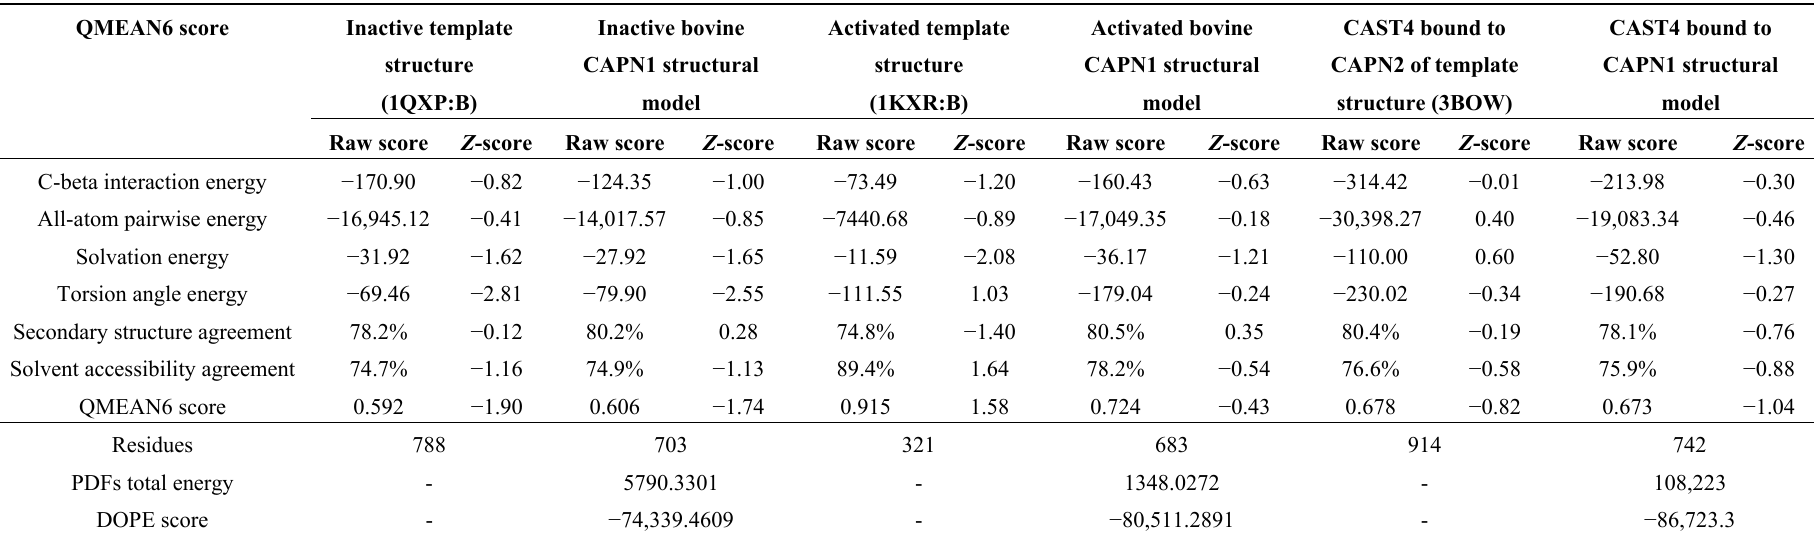
Table 2. Estimating the quality of protein structural models in order to rank